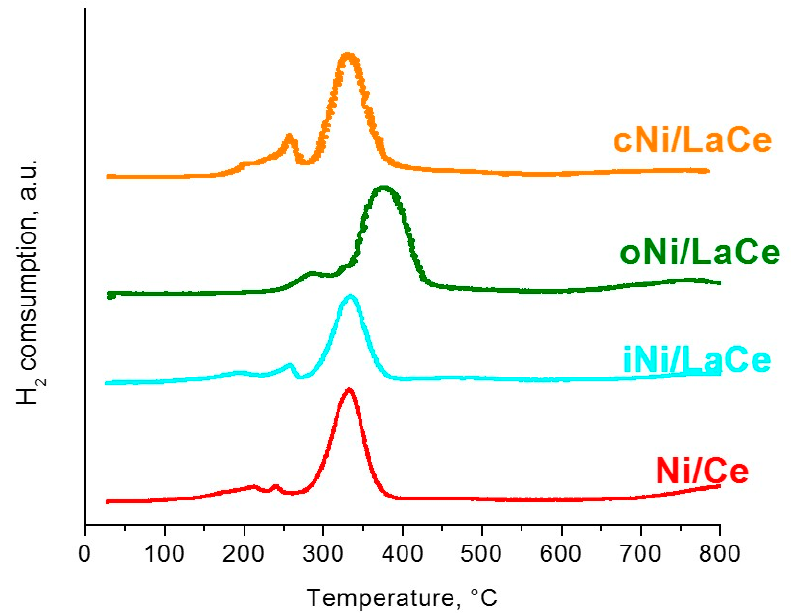
Figure 2. TPR patterns of the catalysts.